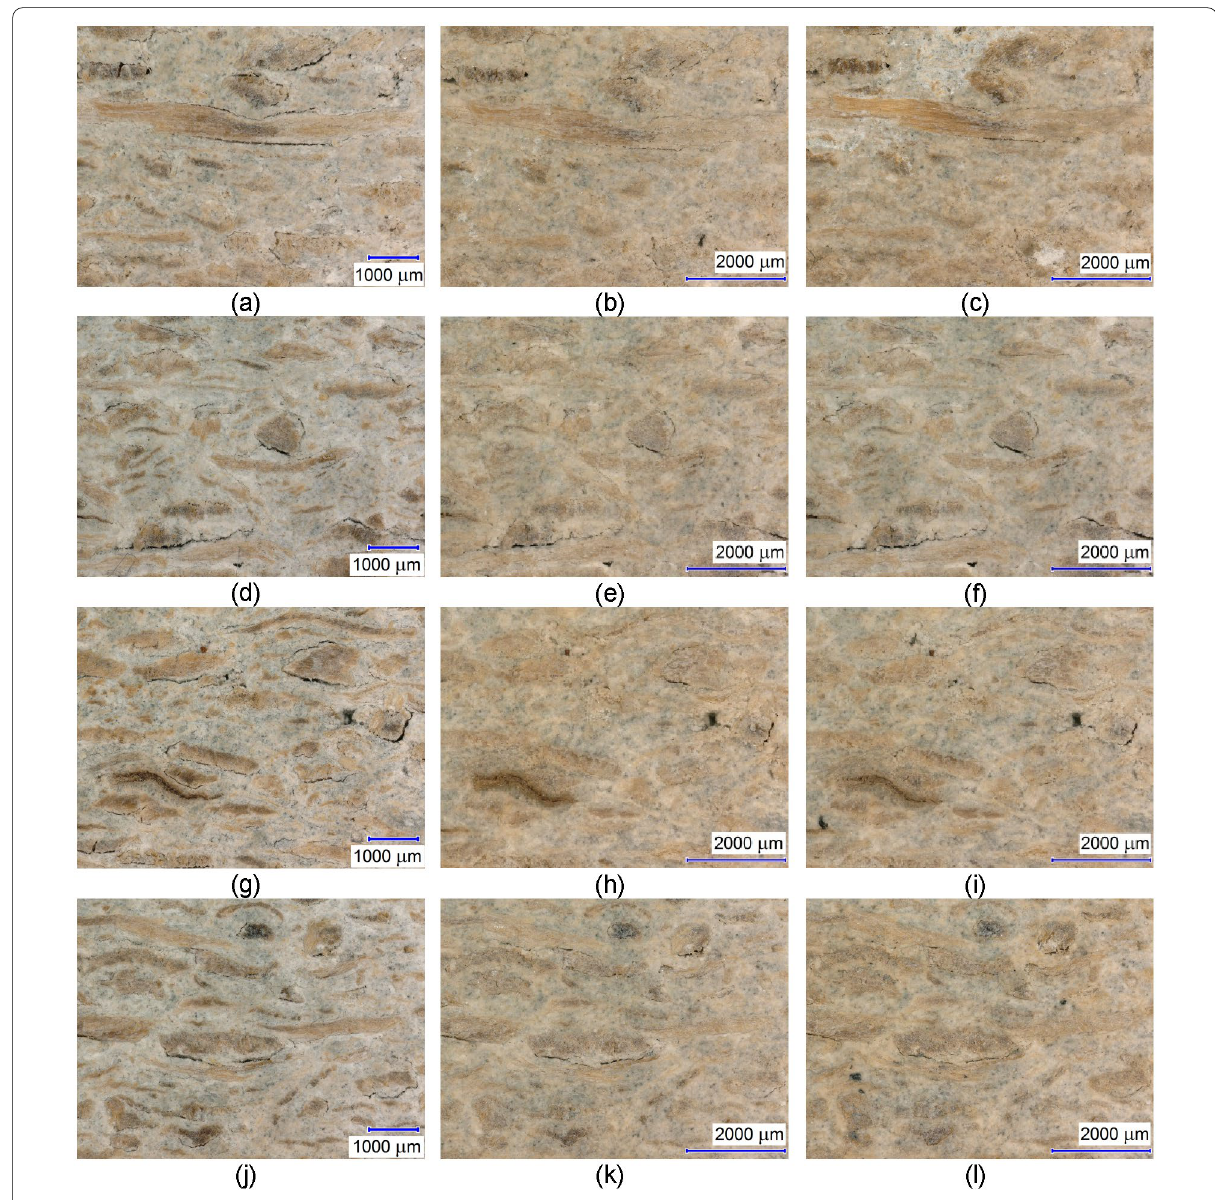
Fig. 19 Structure of boards REF: after a 1, b 5, c 10 cycles; LI10: after d 1, e 5, f 10 cycles; SW07: after g 1, h 5, i 10 cycles; L10/S07: after j 1, k 5, l 10 cycles in accordance with EN 321 (edge of the board, i.e. surface in the direction of